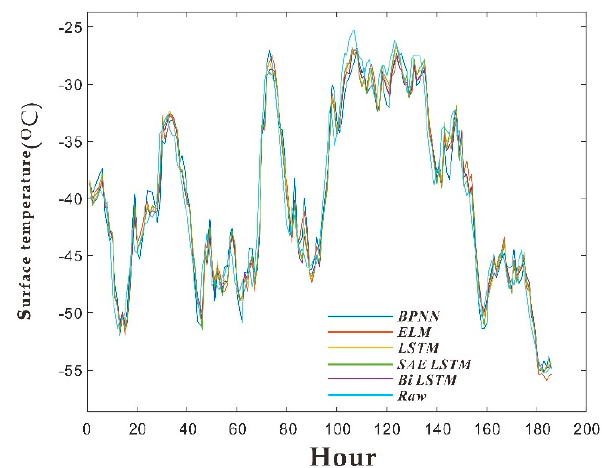
Figure 14. The test set performance of five prediction models for temperature prediction.